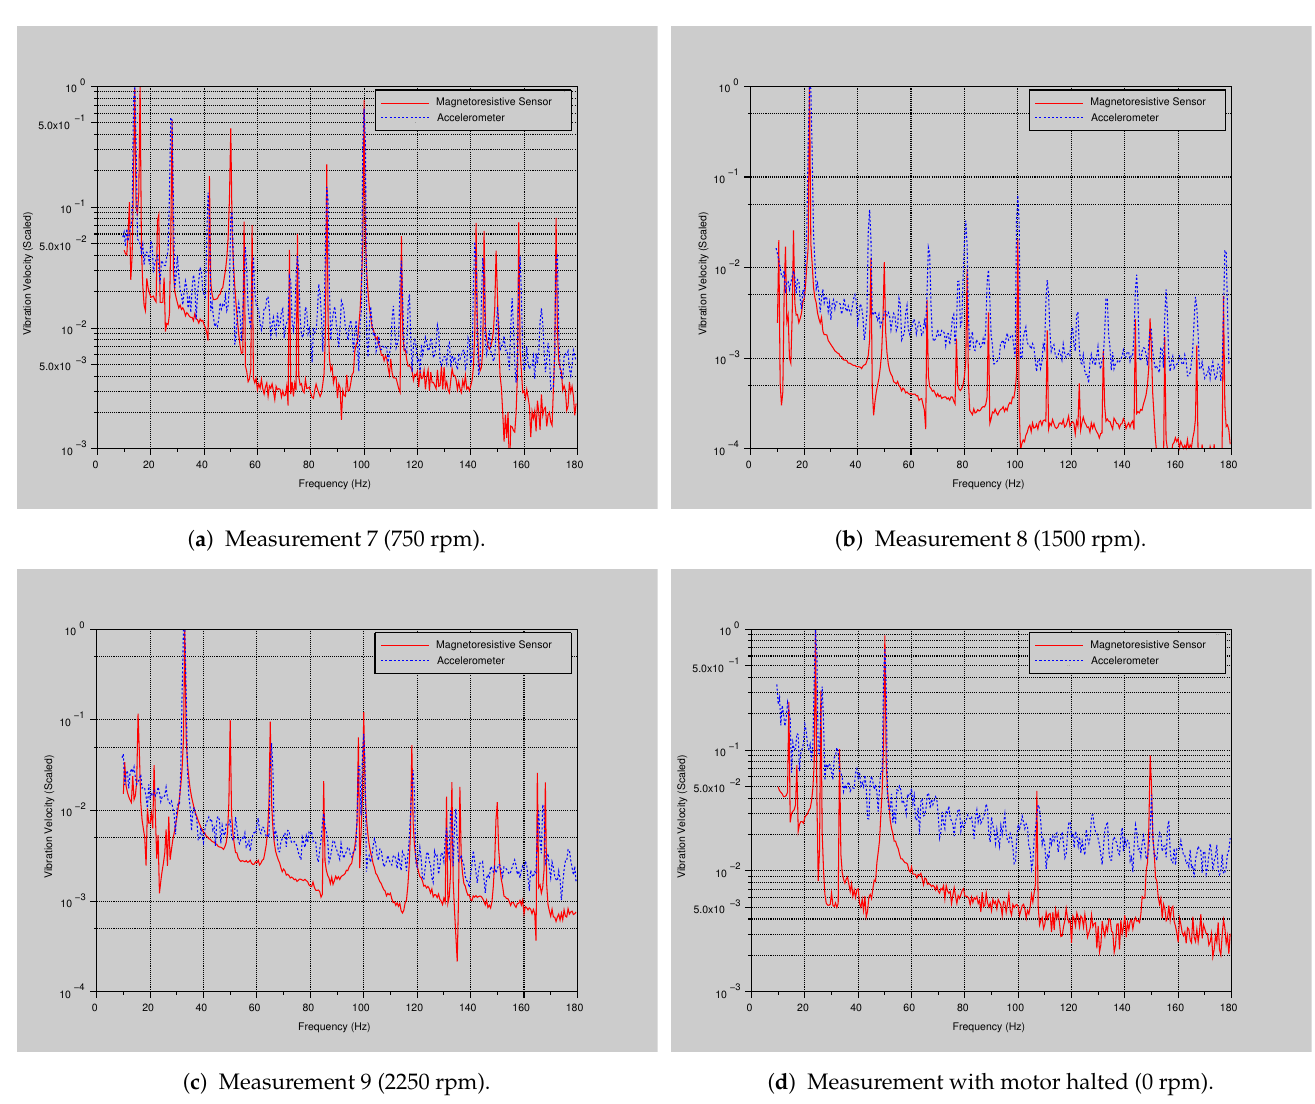
( d ) Measurement with motor halted (0 rpm). Figure 9. Spectral analysis of velocity vibrations on the vertical axis at ( a ) 750, ( b ) 1500, ( c ) 2250 rpm and ( d ) motor halted. Full line: magnetoresistive sensor; dashed line: